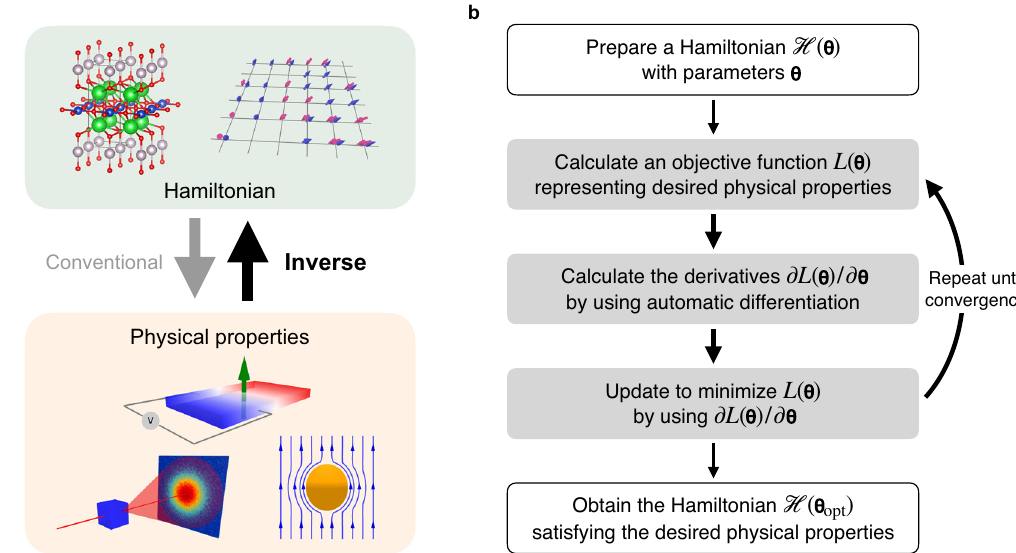
Fig. 1 Inverse design of Hamiltonian. a In the conventional approach, the Hamiltonian is fi rst constructed based on phenomenology or fi rst principles, and then, the optimal parameters of the Hamiltonian are explored through physical properties calculated from the Hamiltonian. In contrast, in the inverse approach, the desired physical properties are prepared fi rst, and then, the Hamiltonian to realize them is obtained directly. b Flowchart proposed in the present study to solve the inverse problem by using automatic differentiation. First, we prepare a Hamiltonian H ð θ Þ that depends on parameters θ . Next, we calculate the objective function L ( θ ), which represents the desired physical properties. By optimizing θ to minimize L ( θ ), we obtain a Hamiltonian H ð θ opt Þ that satis fi es the desired physical properties, where θ opt are the parameters after the